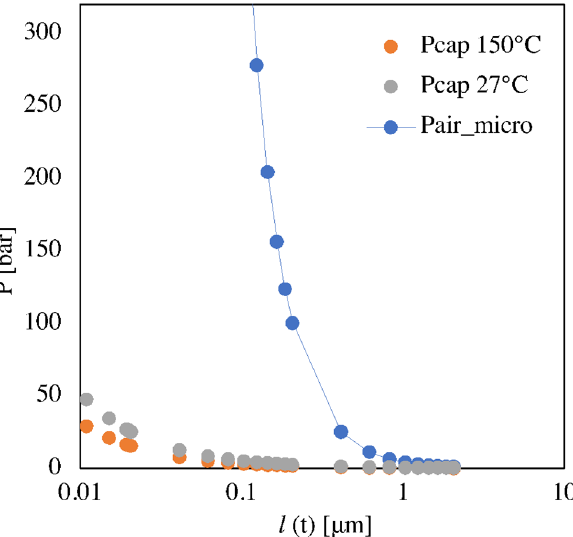
Figure 3. Capillary and trapped air pressure evaluated for microstructure with respect to the distance between the polymer front and the unfilled edge, namely l(t) .